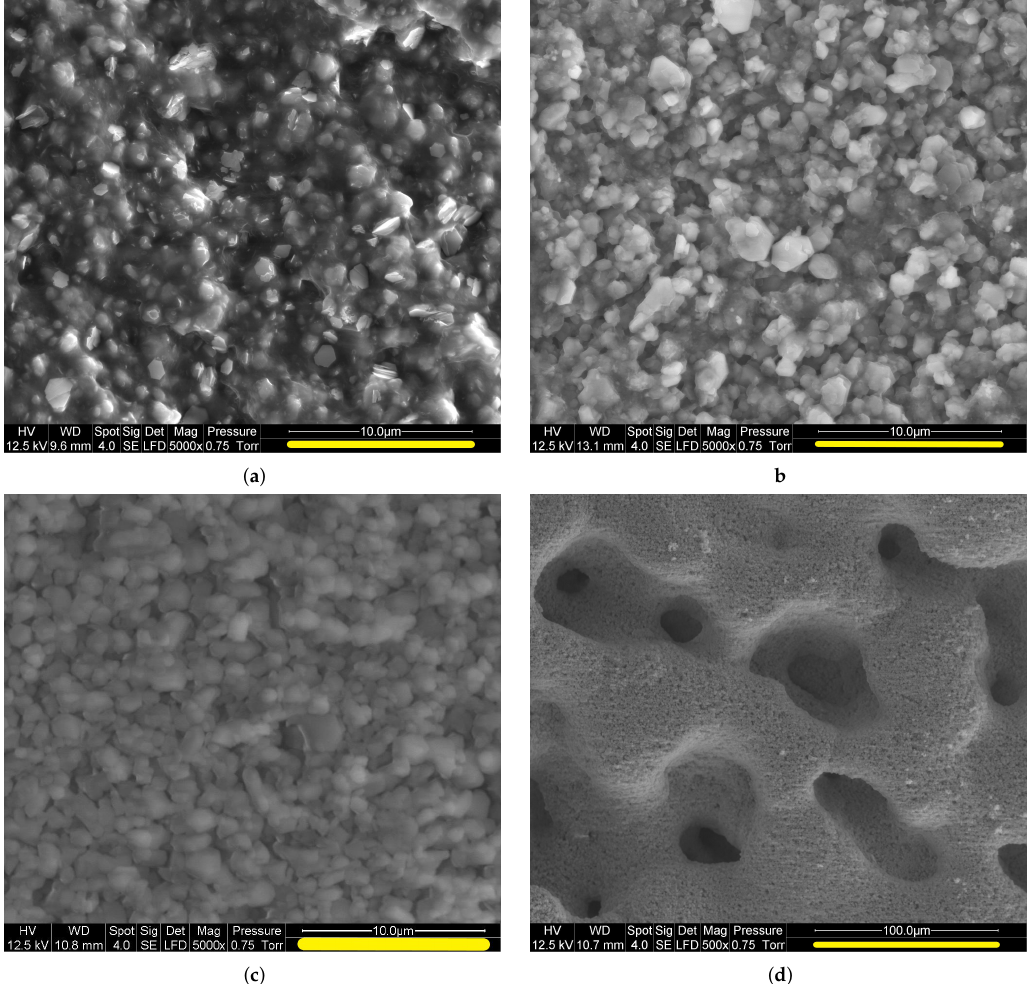
Figure 2. SEM observations of the outer surface of the material in the successive states [S0] ( a ), [S1] ( b ) and [S2] ( c , d ). The yellow streaks correspond to 10 µ m in ( a – c ) and to 100 µ m in ( d